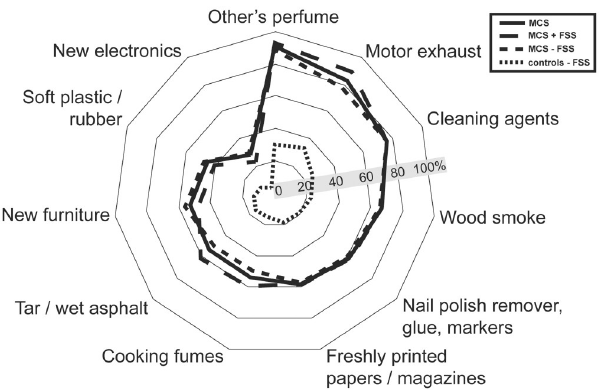
Fig 1. Prevalence of participants that have experienced unpleasant reactions when exposed to any of these 11 types of common odours or airborne chemicals. Abbreviations: MCS = Multiple chemical sensitivity; FSS = functional somatic syndrome; MCS all = all participants meeting criteria for multiple chemical sensitivity; MCS + FSS; participants meeting criteria for multiple chemical sensitivity and one or more comorbid FSS. MCS � FSS = participants meeting criteria for multiple chemical sensitivity but not comorbid